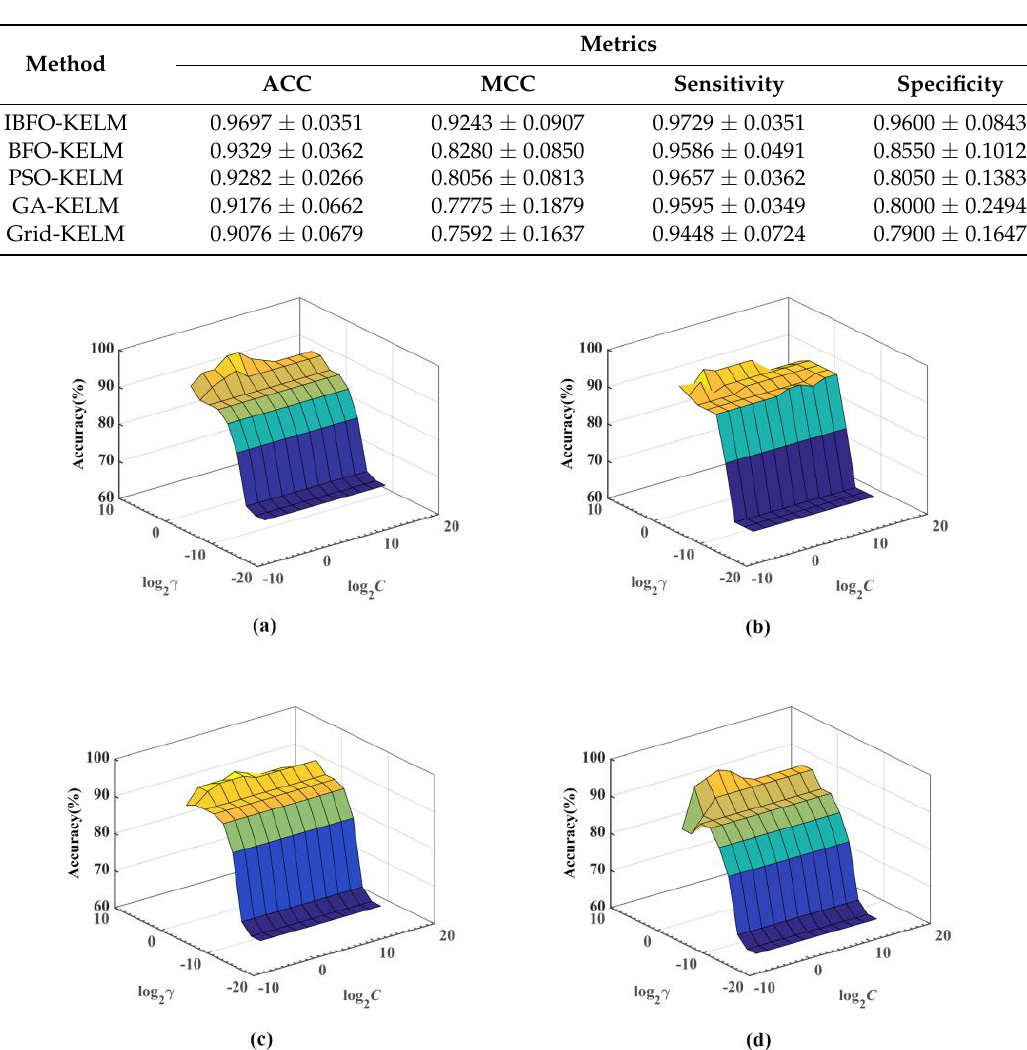
Table 5. Classification performance obtained by the five methods in terms of ACC (classification accuracy), MCC (Matthew’s correlation coefficient), sensitivity, and specificity.